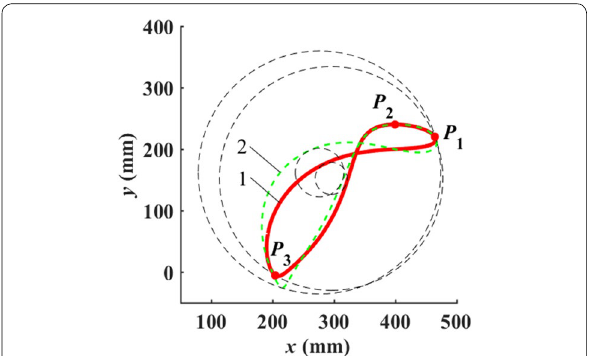
Figure 13 Track comparison of the two sets of parametric solutions